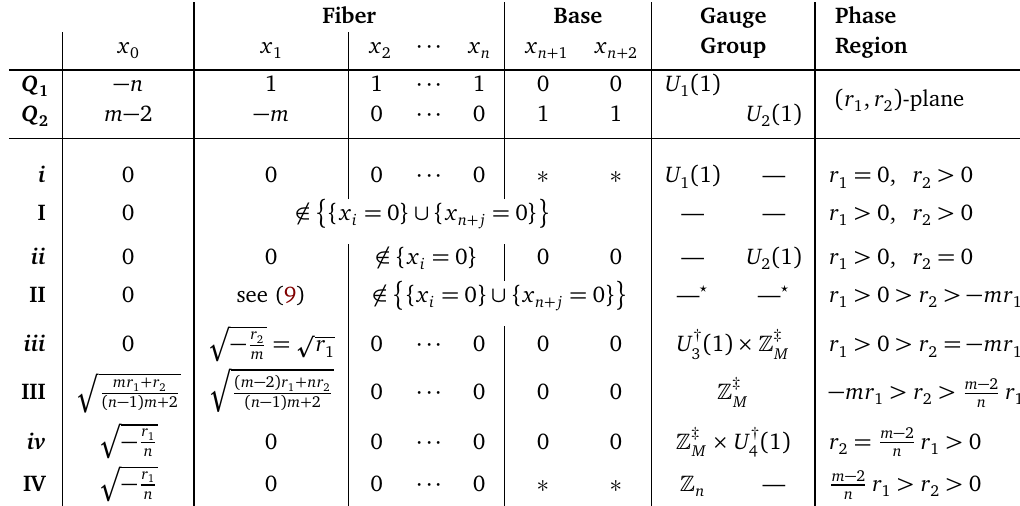
Table 1: The cyclic listing of the phases (I–IV) and boundaries ( i–iv ) of the GLSM (2) Since x , x cannot both vanish, their vevs break U n + 1 n + 2 ( 1 ) → (cid:90) ( x ) = − n ; correspondingly, (5e) reduces to | ( − n ) σ U since Q n 1 1 0 is a hybrid phase in which a Landau-Ginzburg (cid:90) ) over the base- (cid:80) 1 = (cid:80) ( x , x n + 1 n + 2